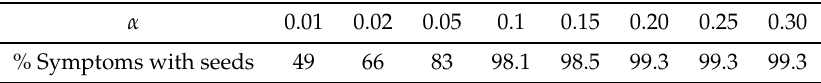
Table 1. The extensiveness of seeds depending on α values: proportion of symptoms including at least a seed pixel.